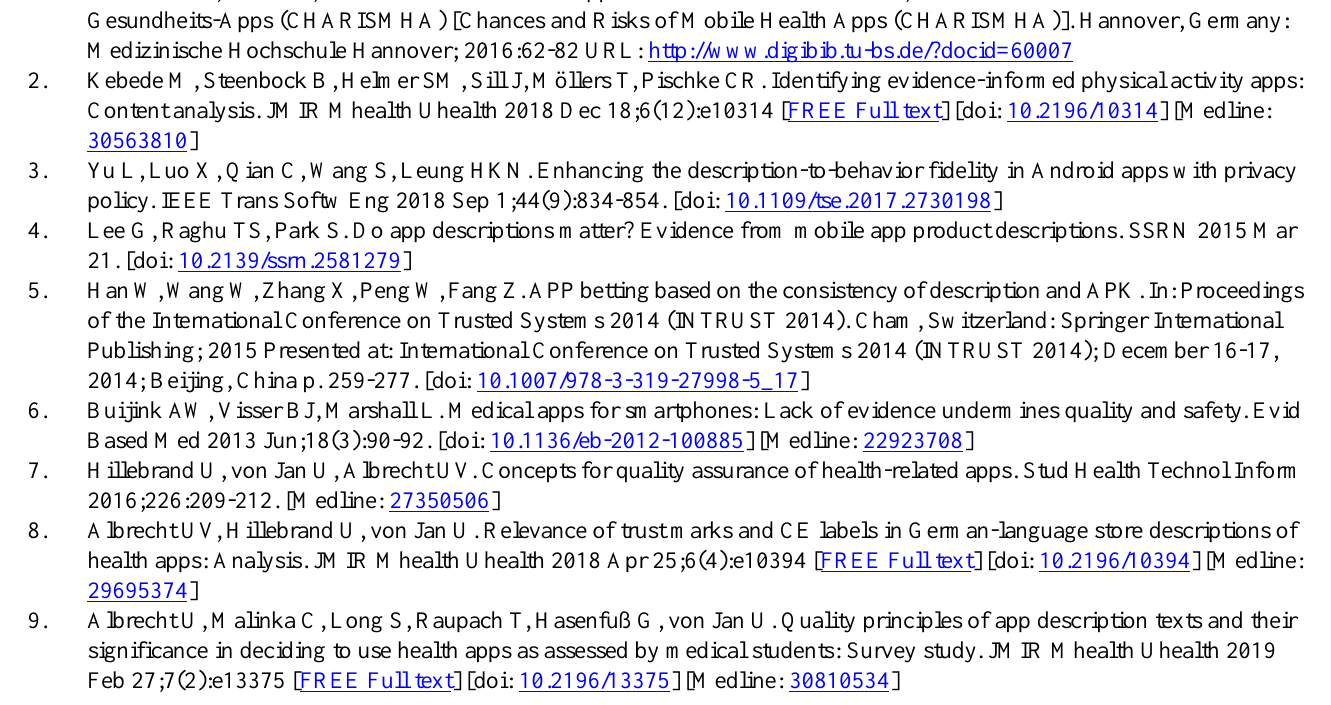
Table D-1 (group A): Results of the regression analysis for group A for changes from assessment 1 (A1) to a more critical assessment in assessment 2 (A2) versus sufficiency of the information provided for assessing the nine quality principles; Table D-2 (group B): Results of the regression analysis for group B for changes from A1 to a more critical assessment in A2 versus sufficiency of the information provided for assessing the nine quality principles. Reference category for both tables was “no.” NR²: Nagelkerke’s R